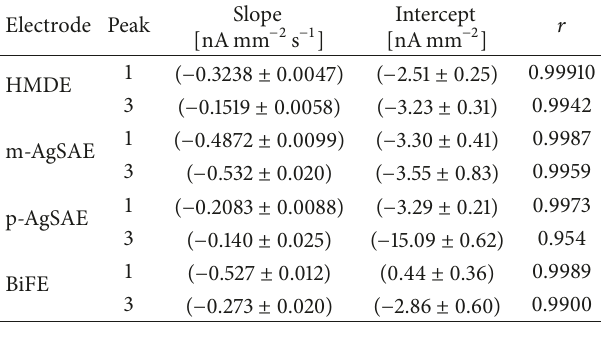
Table 5: Parameters of the dependences of 𝑗 𝑝 on 𝑡 (DPAdSV, BRB Table 6: Parameters of the dependences of 𝑗 𝑝 on 𝑐 acc (pH 5.0 (BiFE), 6.0 (the other electrodes)), 𝐸 (pH5.0(BiFE),6.0(theotherones)), 𝐸 = +200 mV, 𝐸 = in fin − 1300mV, V = 40 mVs −1 , pulse height = − 50 mV (BiFE) and − 60mV V = 40mVs −1 , pulse height = − 50 mV (BiFE), − 60mV (the other (the other electrodes), pulse width = 60ms (BiFE) and 40ms (the ones), pulse width = 60ms (BiFE), 40 ms (the other ones), and 𝑐 other electrodes), 𝐸 = +200 mV, 𝑡 = 0–90 s (HMDE), 0–70 s (m- acc acc AgSAE), 0–40 s (p-AgSAE), and 0–50 s (BiFE), and 𝑐 = 2.0 × DAN 10 −7 molL −1 ); 𝛼 = 0.05.